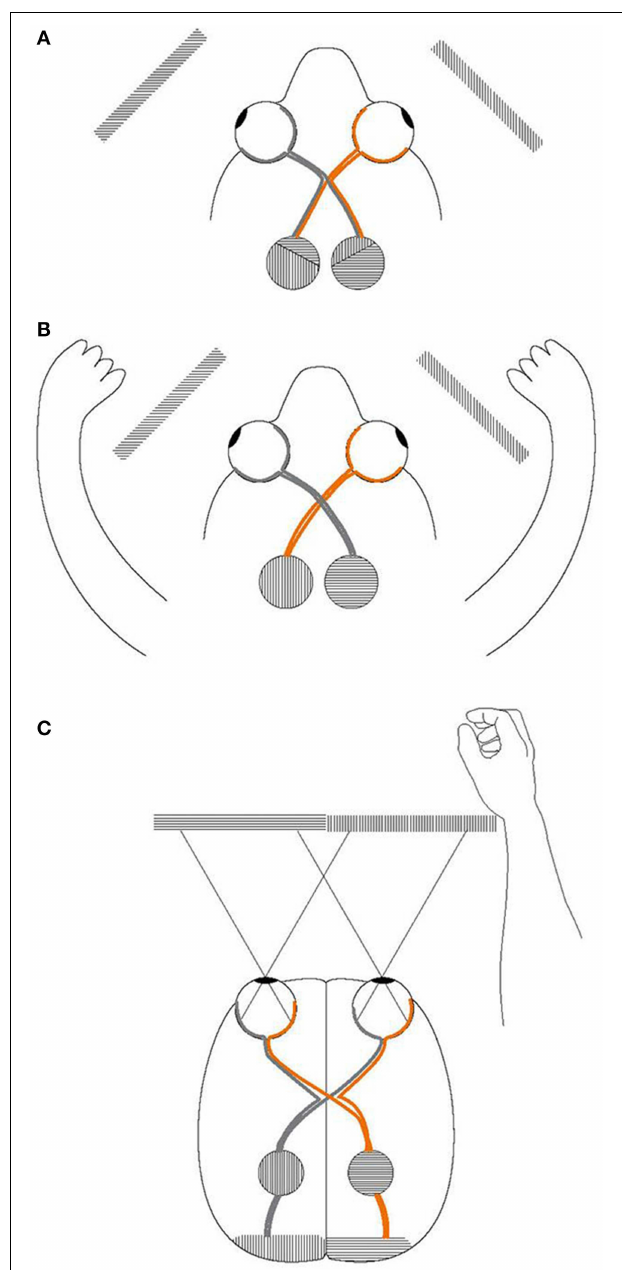
FIGURE 3 | The optic chiasm (OC) in three types of vertebrates. Filled circles represent the superior colliculus (SC). Rectangles represent portions of the left and right visual hemifield. (A) Limbless snakes and caecilians have relatively high proportions of ipsilateral retinal projections, similar to cyclostomes. (B) In animals with laterally placed forelimbs, visual, motor, tactile, and proprioceptive information concerning the forelimb are processed in the contralateral hemisphere. However, that would not have been possible without evolutionary change in the OC, in this case a reduction of IRP compared with cyclostome-like ancestors (C) The cerebral hemispheres of primates receive visual information solely from the contralateral visual hemifield. Again, that would not have been possible without evolutionary change in the OC, in this case increased IRP from the temporal retina. Cats, arboreal marsupials, and fruit bats have similar visual systems. Reprinted from Larsson (2013) with permission from the author/copy-right